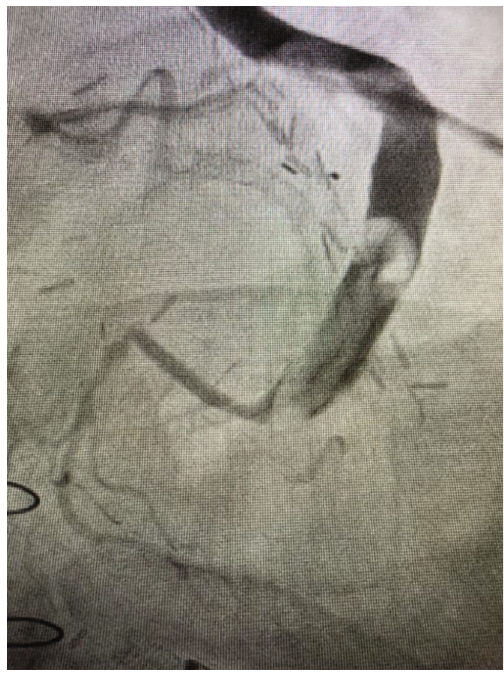
Figure 2: Postrivaroxaban therapy cardiac angiogram of the fi rst OM/terminal circum fl ex with high clot burden showing complete resolution after four weeks of pharmacotherapy.